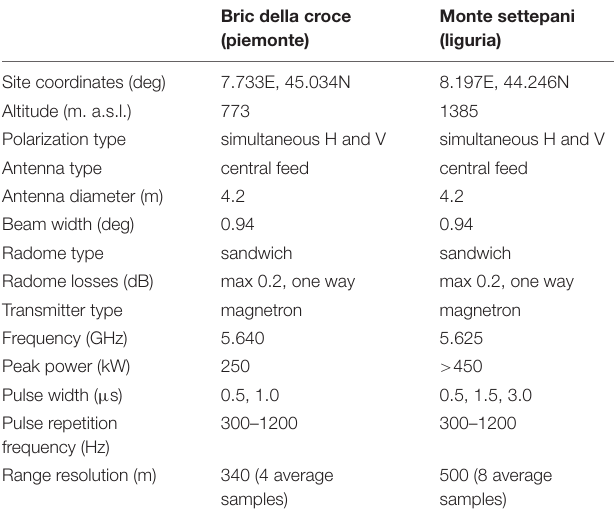
TABLE 1 | Main characteristics of the weather radar used in this